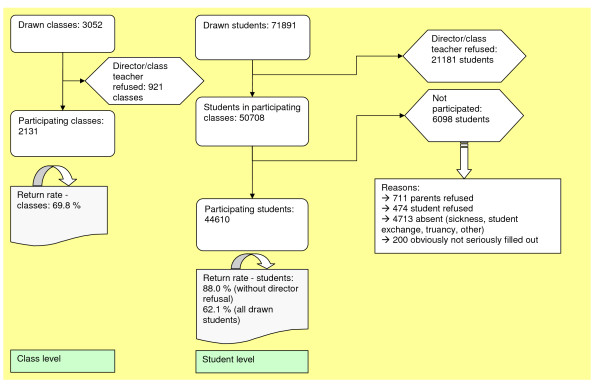
Sample constitution.